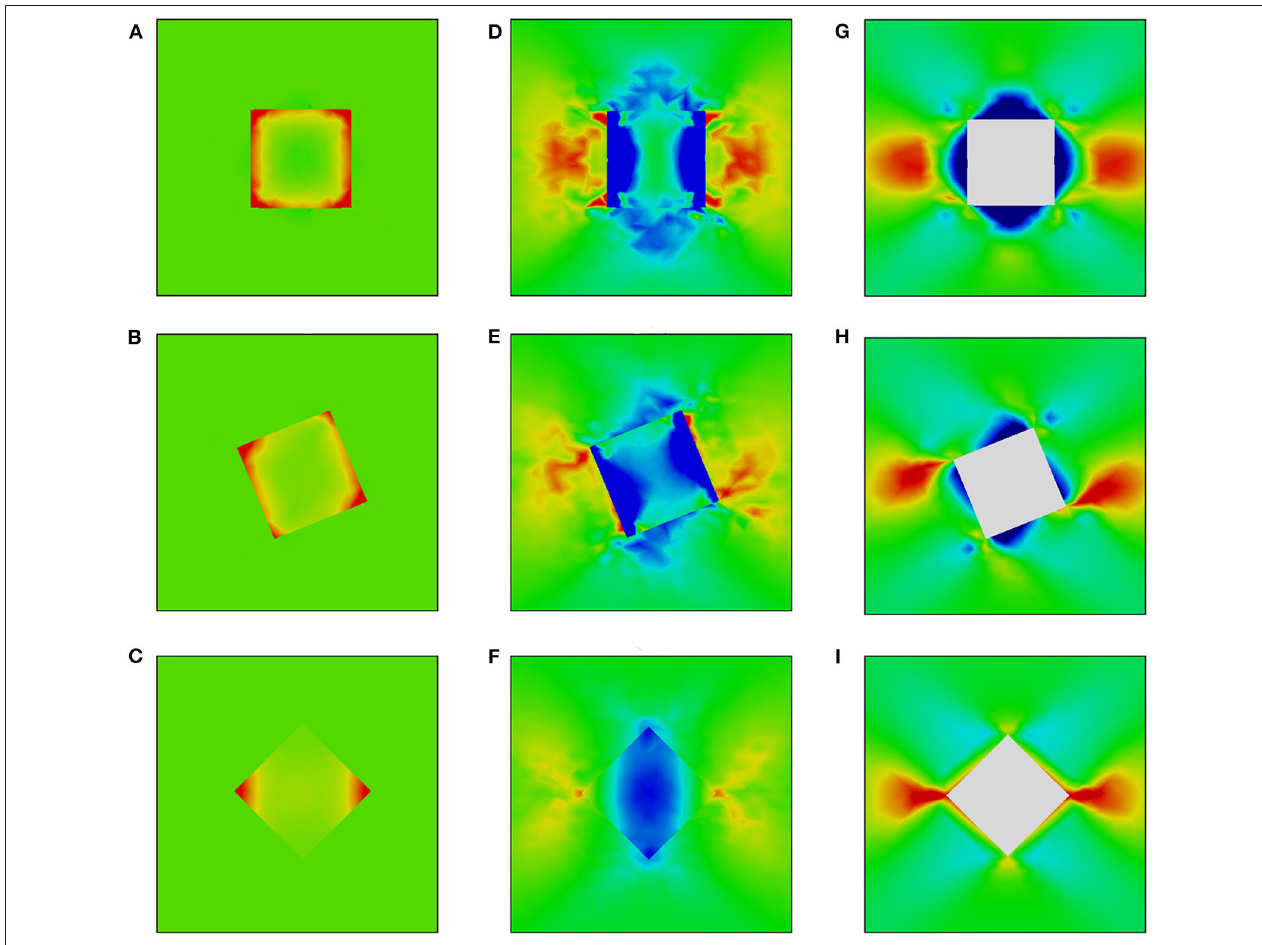
FIGURE 3 | Von Mises stress (A–C) , σ yy (D–F) , and equivalent plastic strain fields (G–I) in the vicinity of a hard inclusion embedded in an elastic-plastic matrix at a distance below the surface (dash-bordered regions in Figures 1D–F ). Color legends are given in Figure 2